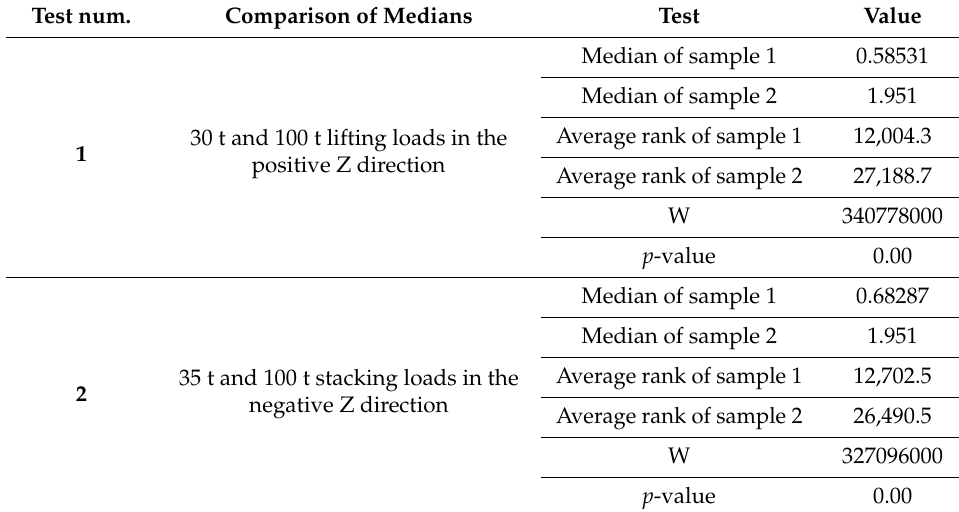
Table 8. Mann–Whitney (Wilcoxon) W-test to compare medians. Test num.